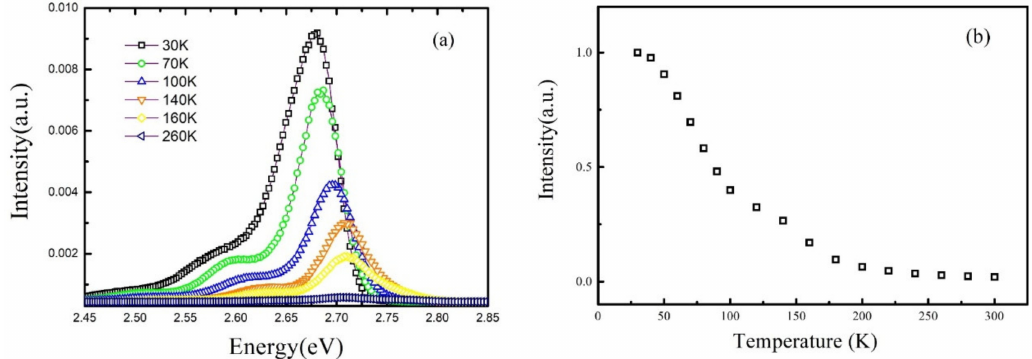
Figure 6. ( a ): The photoluminescence spectra of sample B at different temperature; ( b ): the normalized temperature- dependent integrated PL intensity of sample B.